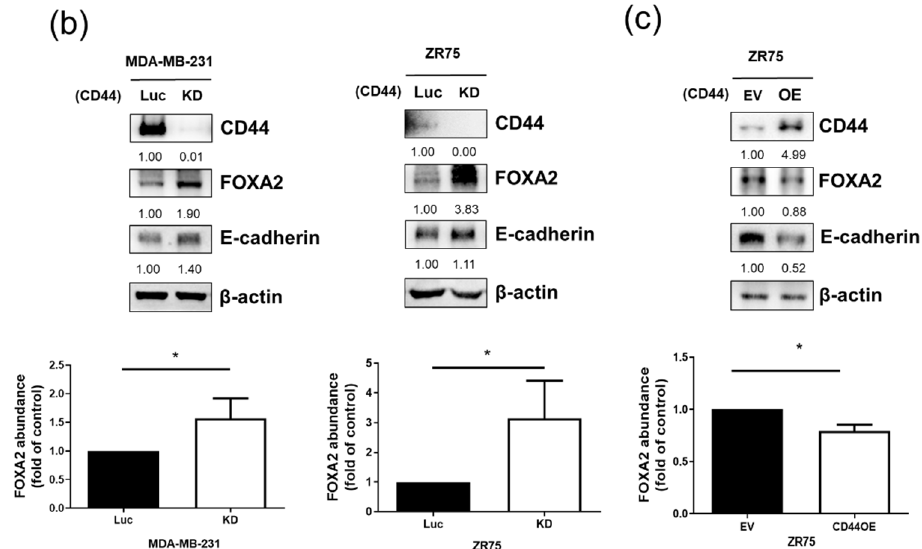
Figure 2. FOXA2 was upregulated in CD44 knockdown cells: ( a ) Human stem cell array table used in RT 2 profiler PCR array experiments (top). Heat map showing the altered expression of stem cell array genes (middle); red, green, and black squares indicate upregulated, downregulated, and nonregulated genes, respectively. Scatter plot showing genes with >2-fold difference in mRNA expression (bottom) in CD44 knockdown MDA-MB-231 cells, as identified by using the human cancer stem cell array. ( b ) Immunoblotting of CD44, FOXA2, and E-cadherin in nontargeting control and CD44 knockdown cells (MDA-MB-231 and ZR75). Knockdown clone 2 was used to knockdown CD44 in MDA-MB-231 and ZR75 cells. ( c ) Immunoblotting of CD44, FOXA2, and E-cadherin in nontargeting control and CD44-overexpressed ZR75 cells. The data are presented as the mean ± SD. * Indicates p < 0.05.